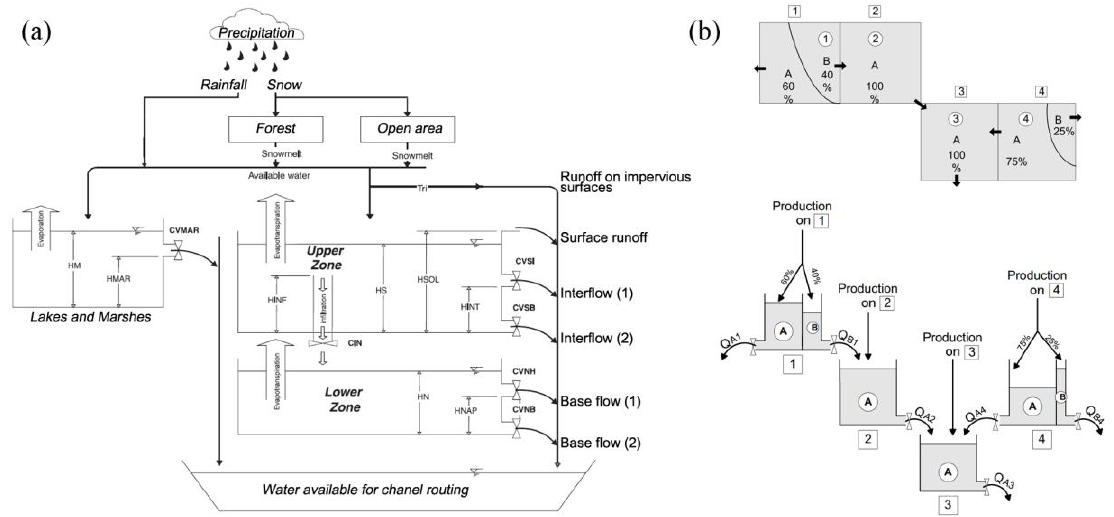
Figure 2. Schematic description of CEQUEAU model: ( a ) production function; and ( b ) routing function [39].